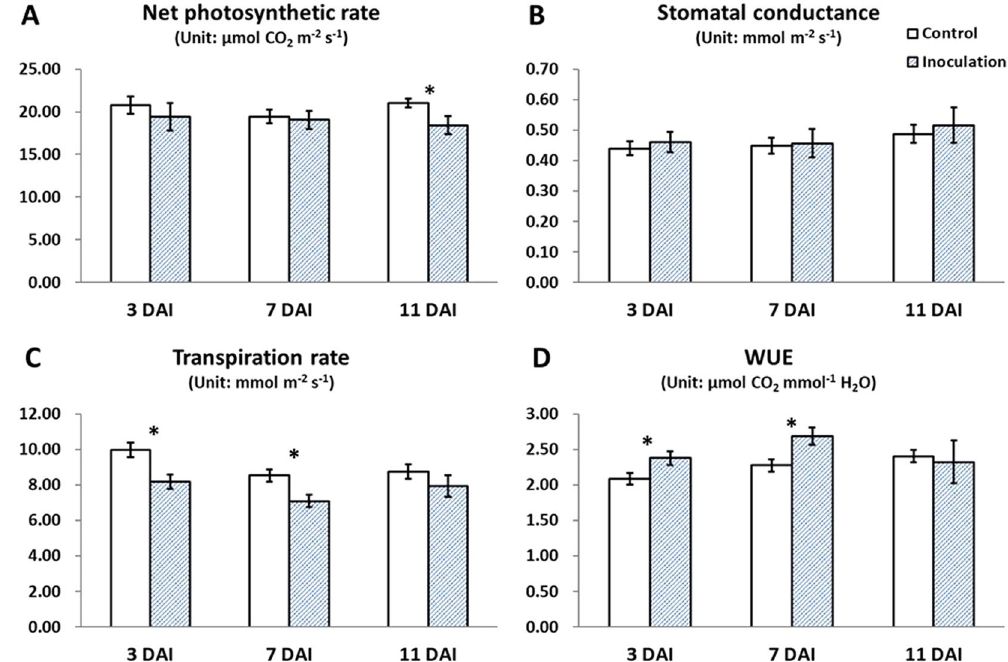
Figure 5. Gas-exchange in poplar trees infected with canker pathogens. ( A ) Net photosynthetic rate. ( B ) Stomatal conductance. ( C ) Transpiration rate. ( D ) WUE, calculated as the formula: net photosynthetic rate divided by transpiration rate. Asterisks indicate treatments that differed significantly from control (ANOVA; * P < 0.05, 6 biological replicates per